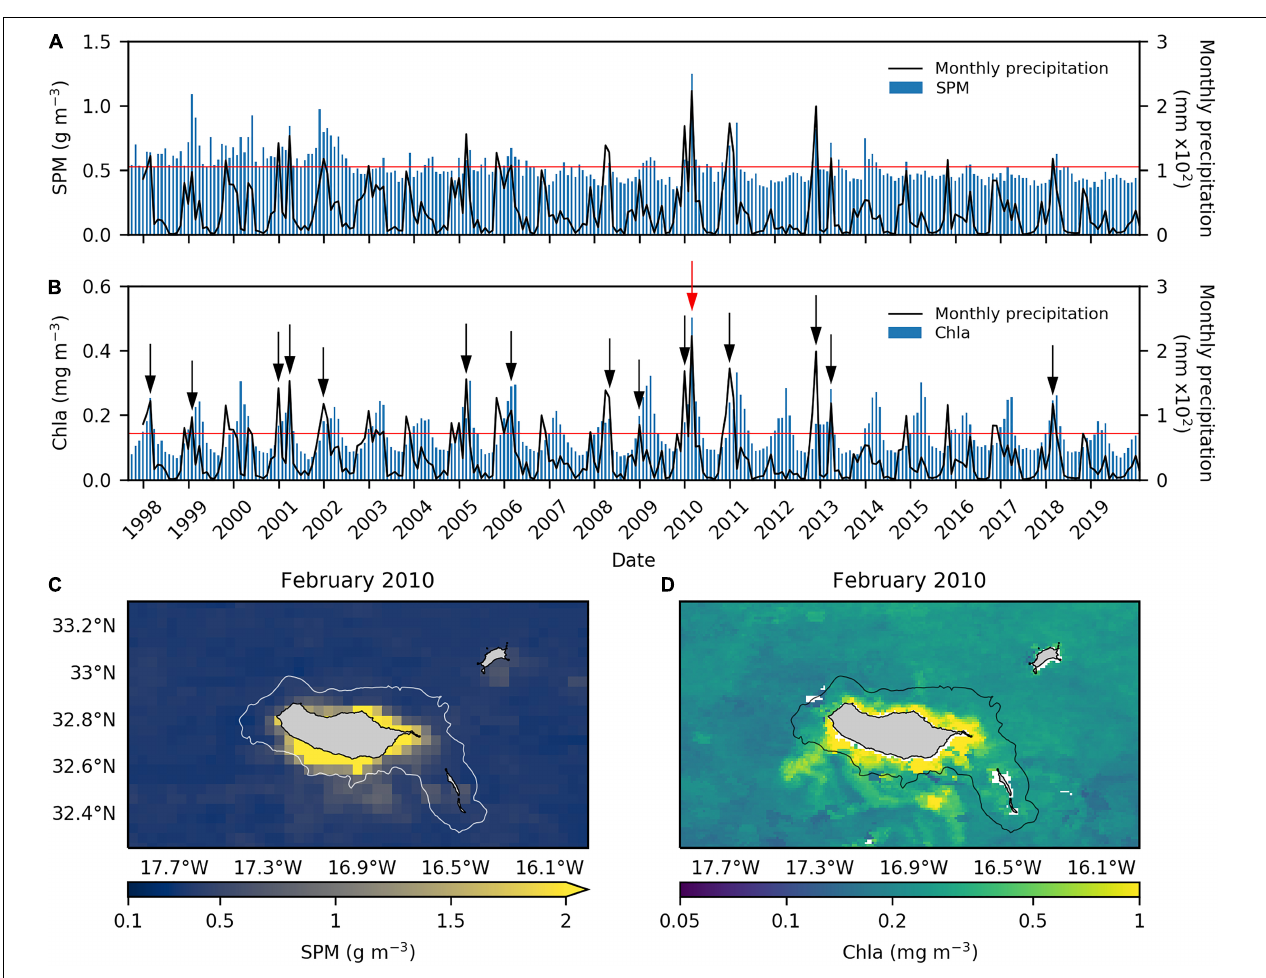
FIGURE 1 | Monthly variability of (A) non-algal Suspended Particulate Matter (SPM; g m − 3 ) and (B) Chlorophyll-a (Chla; mg m − 3 ) concentrations at the inner shelf area (calculated with values within the -2000 m isobath, represented by the white and black line in C,D , respectively) between September 1997 and December 2019 based on satellite data along with monthly accumulated precipitation recorded at 9 meteorological stations distributed over the island (black line). The red line represents the mean, and the black arrows in (B) indicate anomalous Chla concentrations associated with runoff episodes. Satellite images of the regional area of Madeira Archipelago representing the monthly average of (C) SPM and (D) Chla concentrations for the specific episode of February 2010, when the maximum of concentrations occurred (red arrow in B